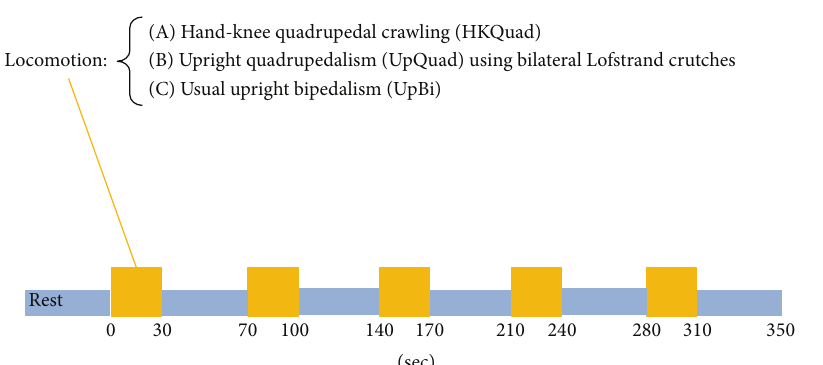
Figure 3: Temporal sequence of the task design. Each task comprised 30 s of locomotion and 40 s of rest, where each pair was repeated five times in total.